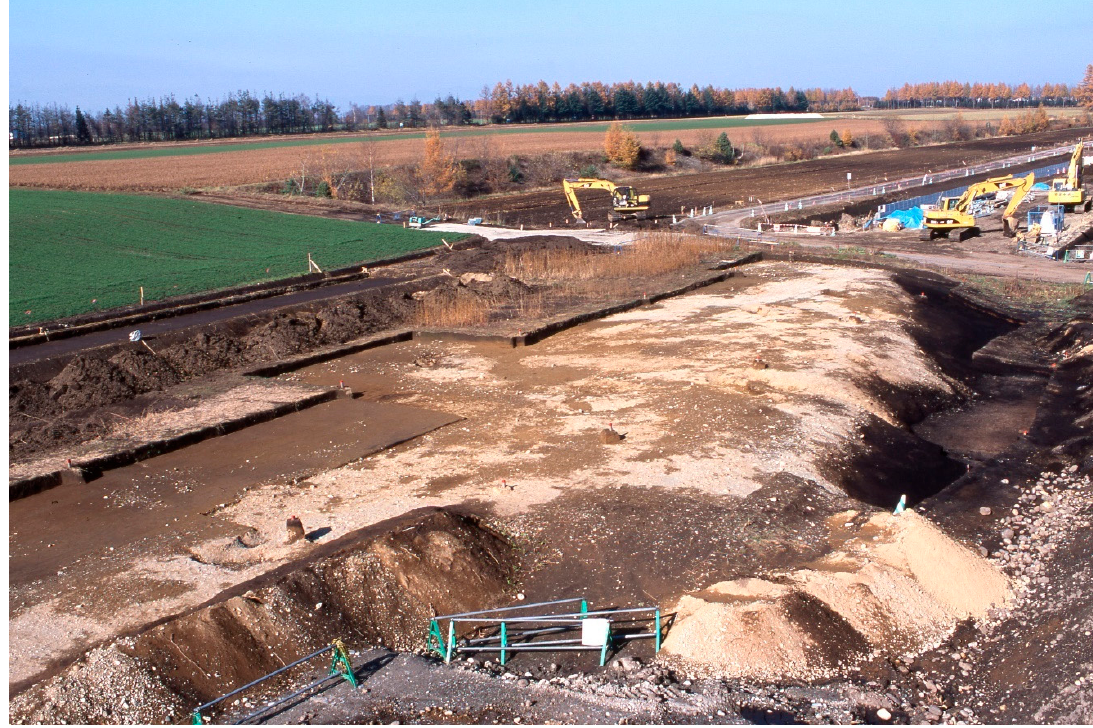
Figure 6. Distant view of excavation at the Taisho-3 site. Reproduced from [90], with the permission of the Obihiro Centennial City Museum.